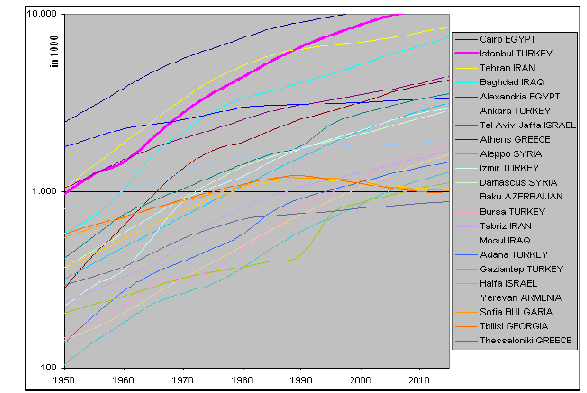
Figure 15: Growth of inhabitants of neighbouring agglomerations on logarithmic scale, based on Data of the World Urbanisation Prospects - Revision 2003